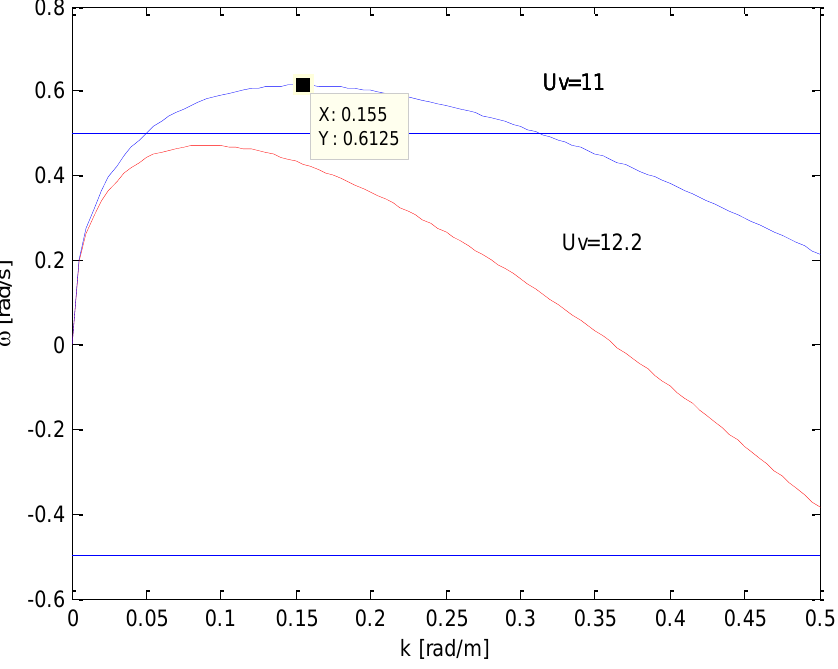
)~ ,(~ Uk  (according to Equation (14)) for a fixed value of the Figure 7. Behaviour of surface current 7U  m/s and for the two different values of the virtual surface current   12.2 11,U  m/s. The dotted point accounts for the maximum point ),( v